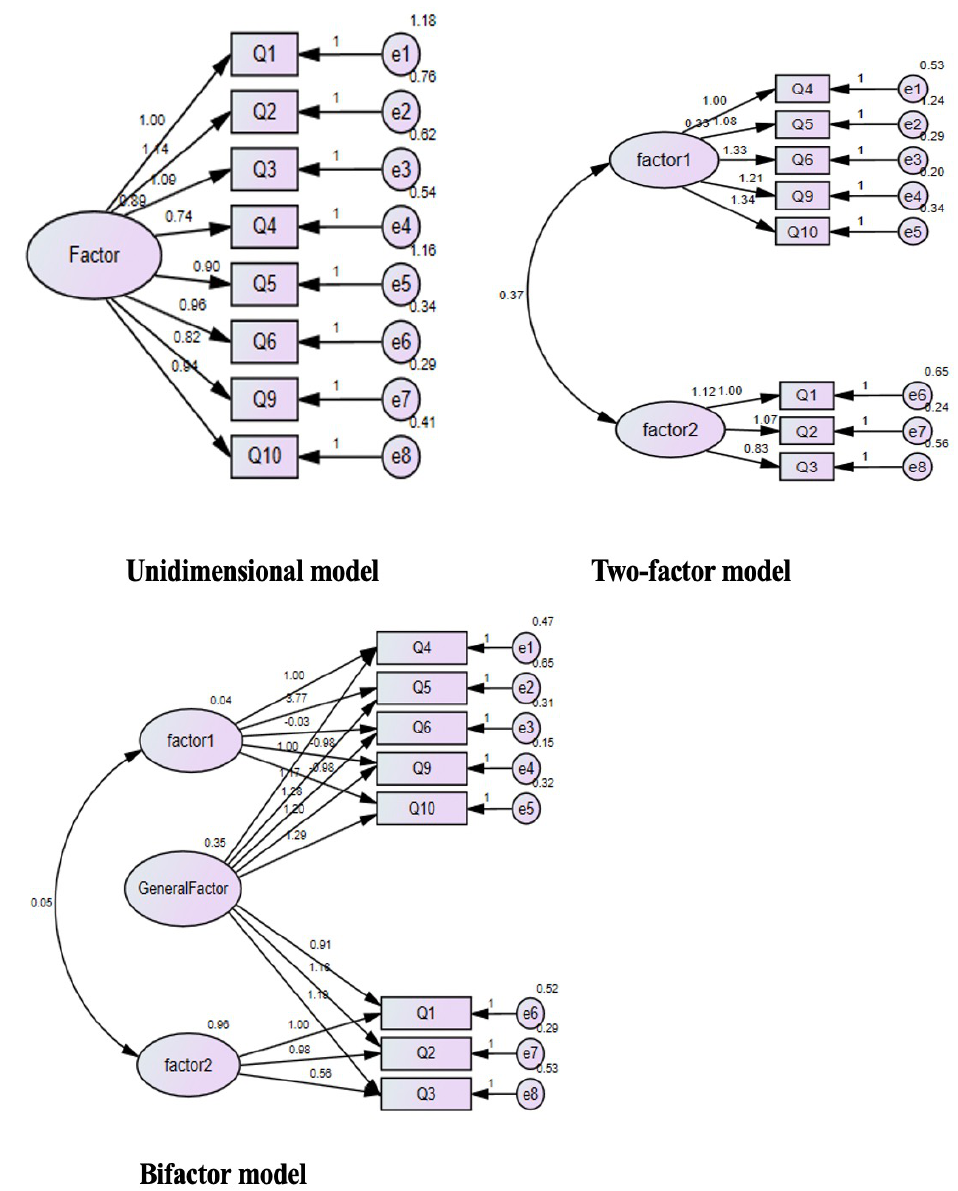
Figure 2. Graphical representation of the three compared measurement models: (1) unidimensional model; (2) two-factor model; (3) bifactor model (factor 1: the awareness of COVID-19 and physiological arousal. factor 2: fear-related thinking).